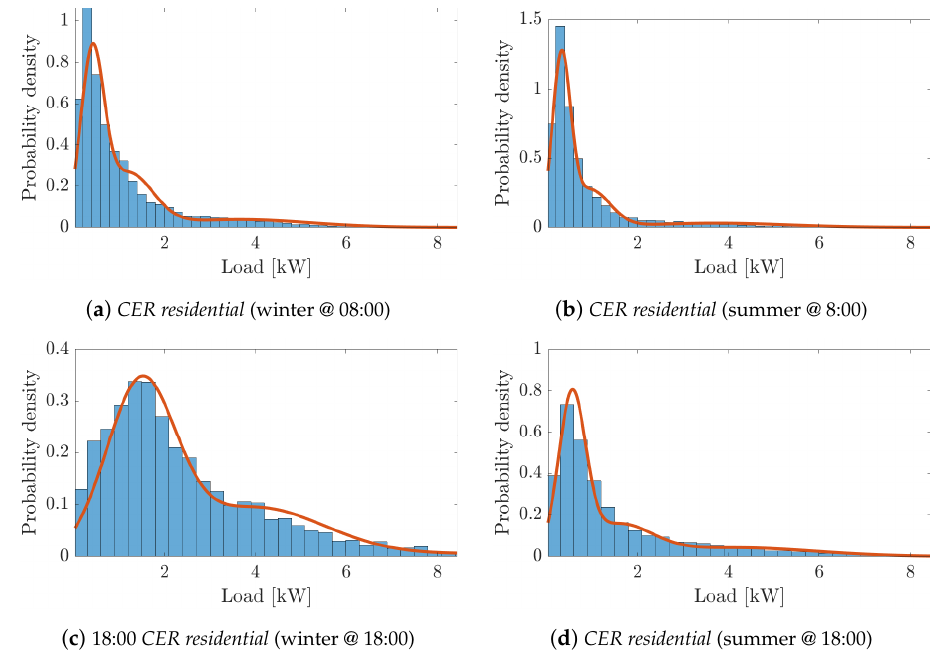
Figure 5. Histograms of the CER residential original LPs and PDFs of the corresponding SLPs (solid lines) at two different times of the day (8:00 and 18:00) in winter and summer, respectively. Histograms computation and GMM PDFs fitting are performed using the same amount of data and refer to the most populated